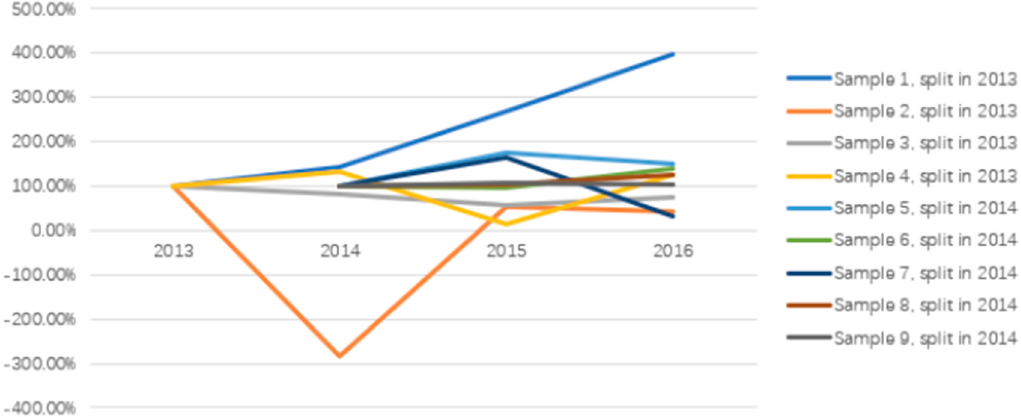
Figure 8. Percentage of change in net profit for the split year and evolution for the following years.